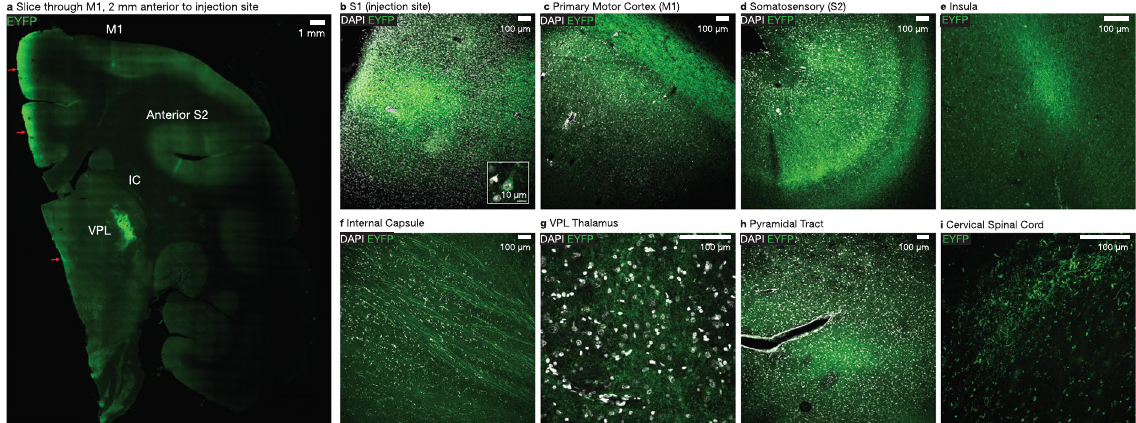
Figure 2. eNpHR3.0 expresses in fibers in downstream brain circuitry, enabling circuit-specific neural modulation. ( a ) AAV5-hSyn-eNpHR3.0-EYFP expression in M1 coronal slice, 4 mm anterior to the injection site in left S1 of Sq. B, indicating expression in downstream projection targets. Red arrows indicate regions where tissue brightness is presumed to be due to aberrations in mounting at the edges of the large slice. ( b ) eNpHR3.0 expression near the injection site in S1. Inset shows representative expressing cell body. ( c – i ) Opsin expression in fibers in brain regions downstream of S1, including in M1 cortex, anterior secondary somatosensory cortex (S2), insula, internal capsule, VPL thalamus, the pyramidal tract at the medulla of the brainstem, and corticospinal tract imaged in the posterior (dorsal) column of the cervical spinal